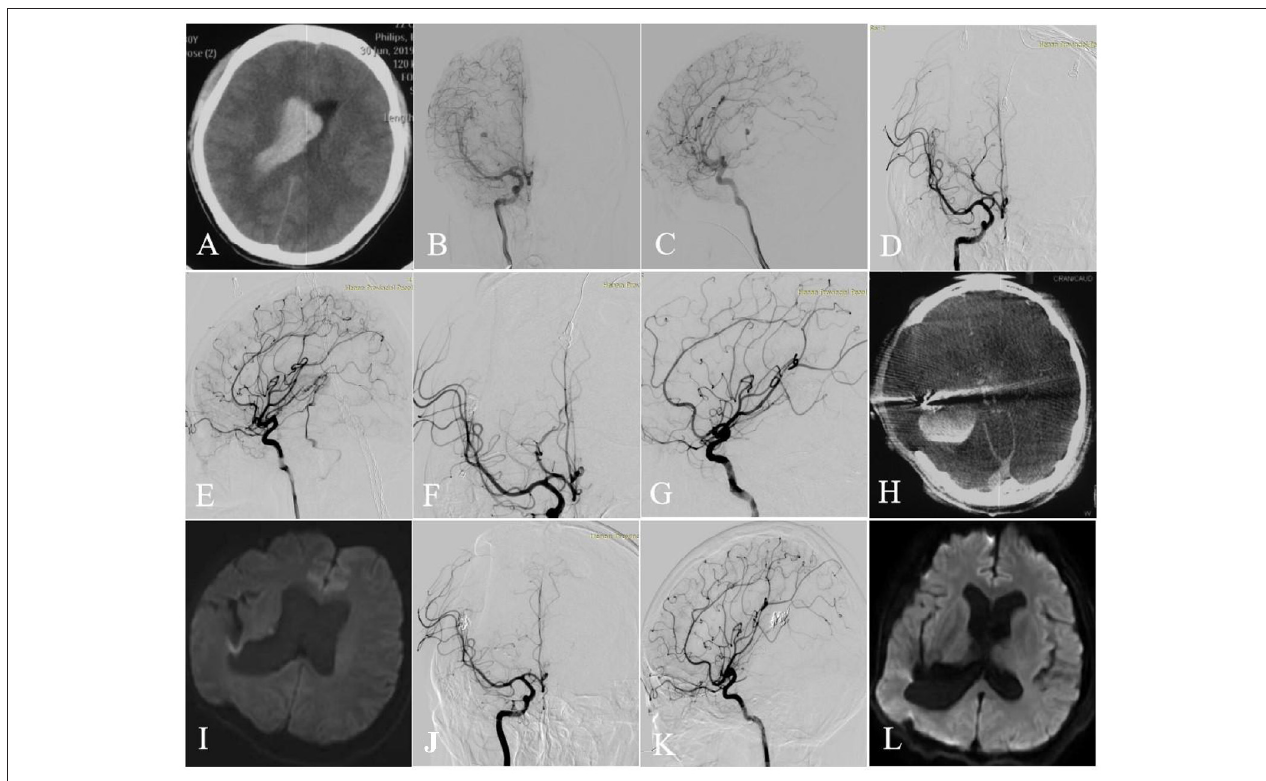
FIGURE 2 | Axial CT image showed intraventricular hemorrhage (A) . Selective DSA of the right ICA [anteroposterior (B) and lateral (C) views] showed that the AVM with an aneurysm (flow related pedicle) located at the temporal lobe was fed by the branches and perforators of ACA, MCA, and ICA and drained a single venous outlet via the cortical cerebral vein. After 3 months, TVE was performed. First, targeted embolization of the aneurysm [anteroposterior (D) and lateral (E) views]. And then the AVM was completely angiographically obliterated at the end of the operation [anteroposterior (F) and lateral (G) views]. Intraoperative intracerebral hemorrhage occurred ( H , Dyna CT). No cerebral infarction was seen on Axial DWI performed 3 days (I) after surgery and then 6 months (L) . The AVM was completely angiographically obliterated at the 6-month follow-up [anteroposterior (J) and lateral (K)